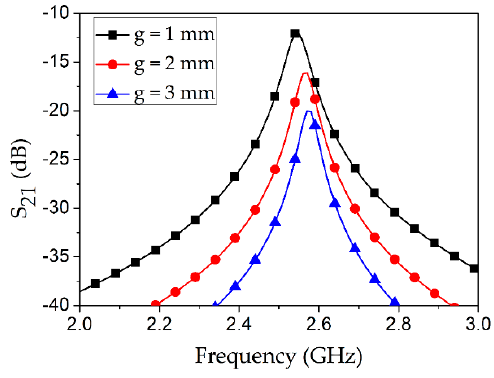
Figure 4. Coupling gap ( g ) investigation for the proposed microwave cavity resonator when the Teflon tube was empty.